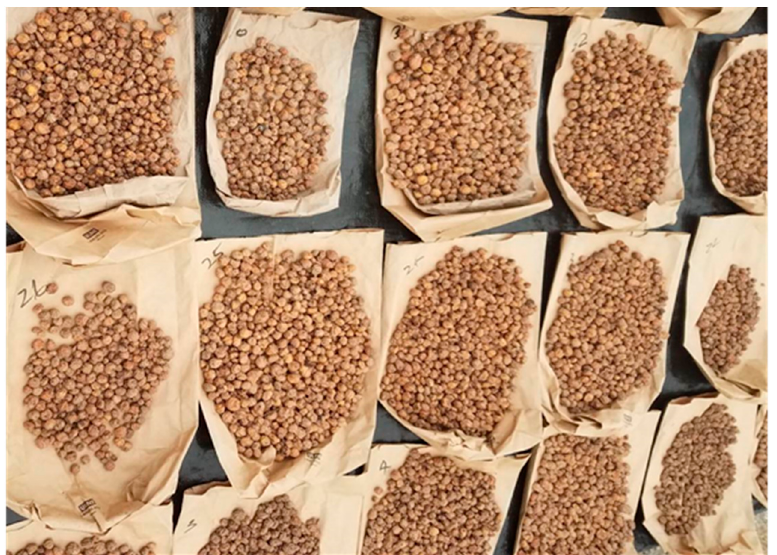
Figure 2. Air drying of freshly harvested tigernut tubers in the hoop house. Low humidity and free air circulation facilitate the drying process and preserve tuber quality. Photo: Albert Ayeni.